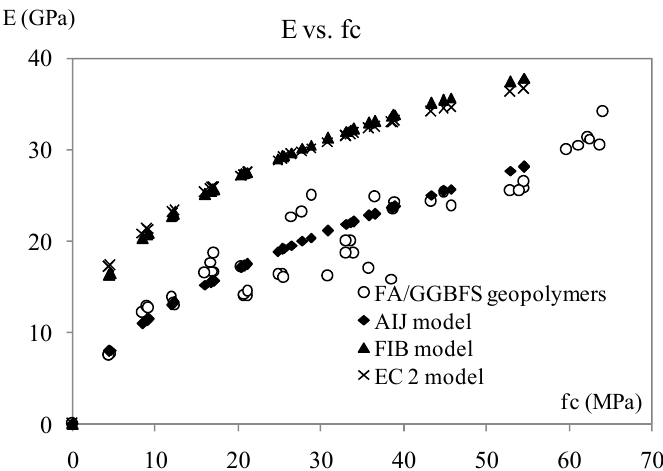
Figure 7. Static elastic modulus of elasticity evolution with compressive strength for the fly ash and ground granulated blast furnace slag blended geopolymer mortars 10N, 30N, and 50N, in comparison with E(f c ) models for cementitious materials.